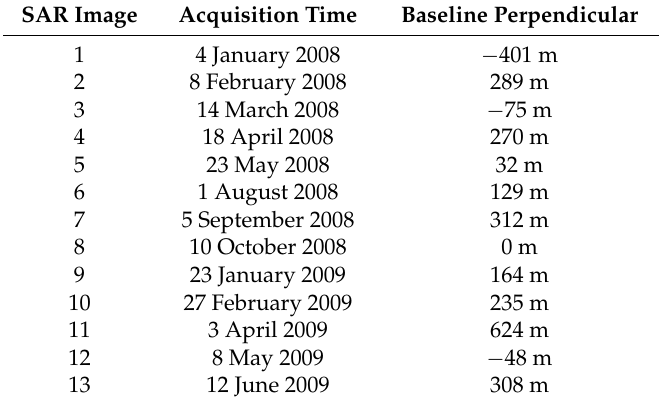
Table 2. Envisat/ASAR archive with acquisition time and length of perpendicular baseline relative to the reference image on 10 October 2008.